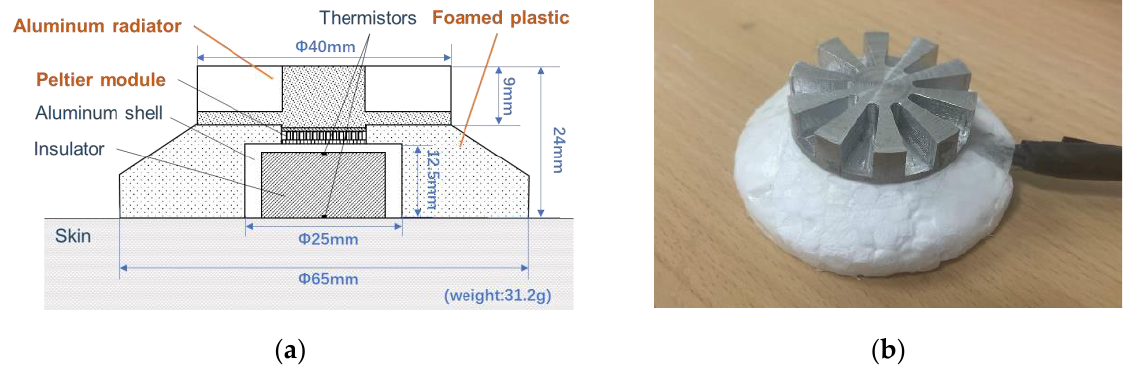
Figure 1. ( a ) Cross-section of the prototype probe and ( b ) external appearance of the probe.